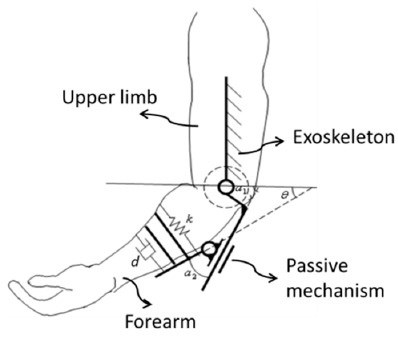
Figure 4. Schematic of the exoskeleton.